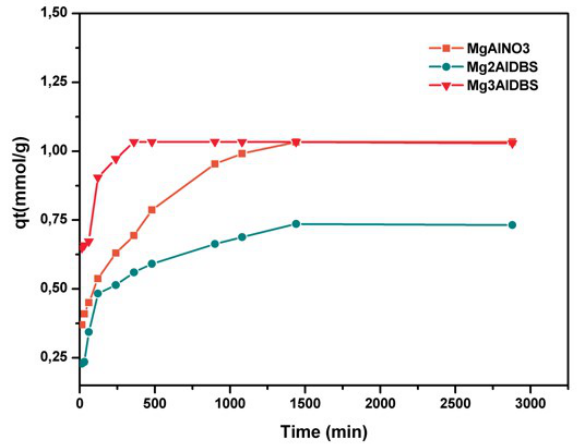
Figure 6. Evolution of BG adsorption on MgAlNO3 and nanohybrids. qt (mmol / g) is the adsorption capacities of the absorbent at time t (min).